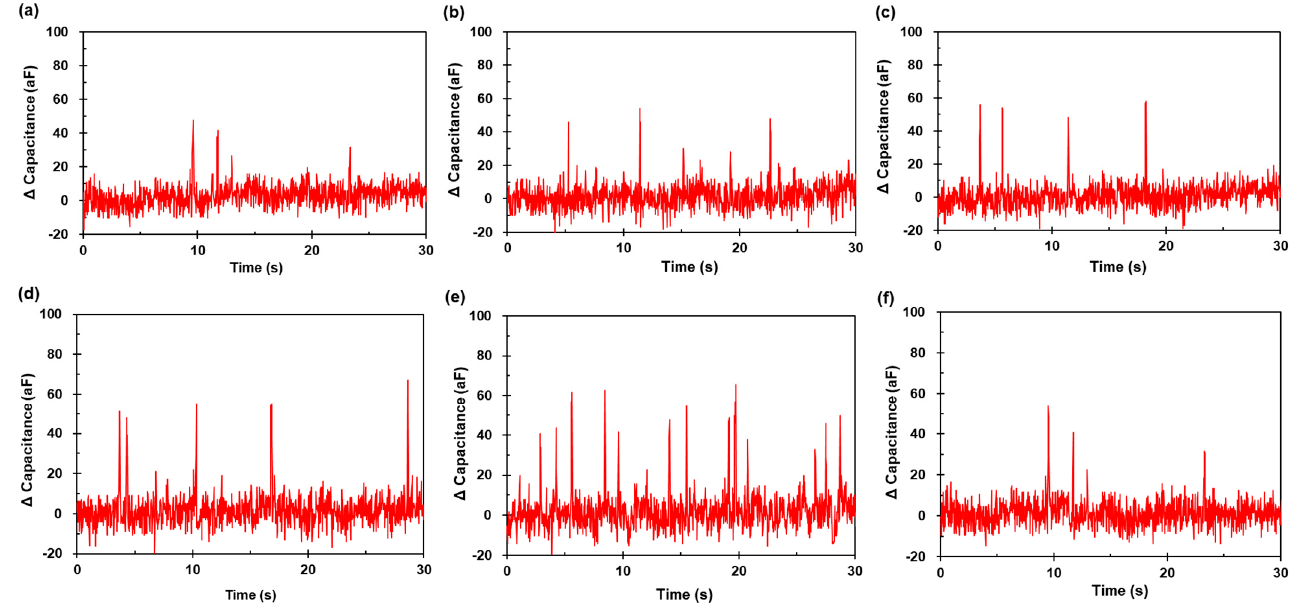
Figure 10. Measured capacitance signals for the aluminum particles ( d = 20 μ m ) under frequency of ( a ) 1.0 MHz, ( b ) 1.2 MHz, ( c ) 1.4 MHz, ( d ) 1.6 MHz, ( e ) 1.8 MHz, and ( f ) 2.0 MHz.